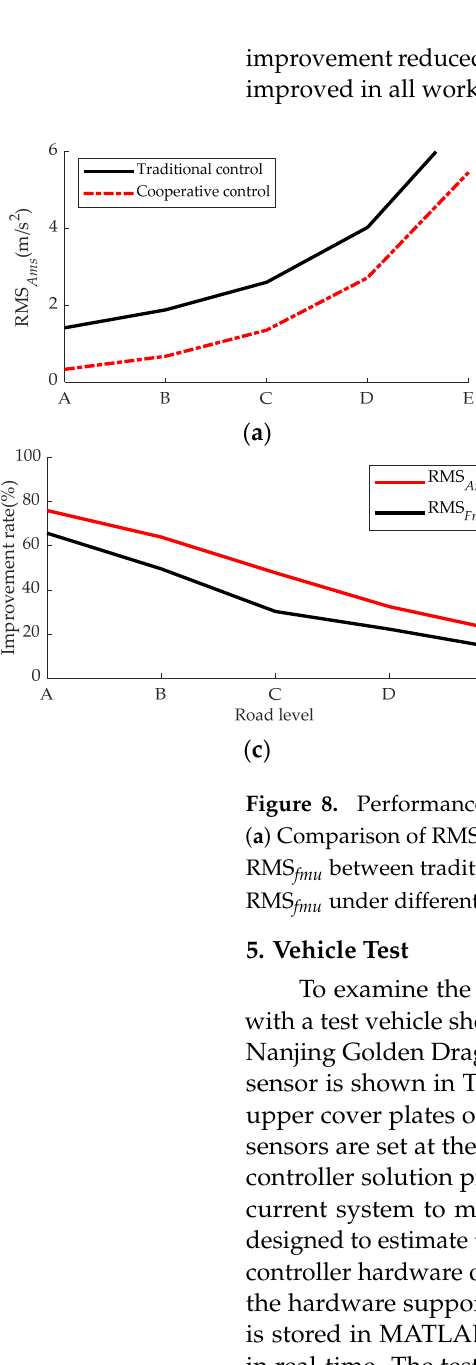
( b ) ( c ) Figure 7. Outsourced mode activation state. ( a ) Solenoid valve actions during inflation in OMA. ( b ) Solenoid valve actions during deflation in OMA. ( c ) Best suspension forces generated by OMA.